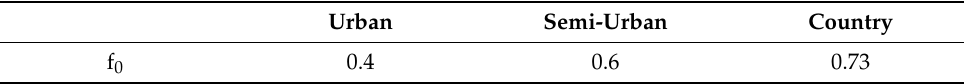
Table 3. Design factor for natural gas pipe [17].